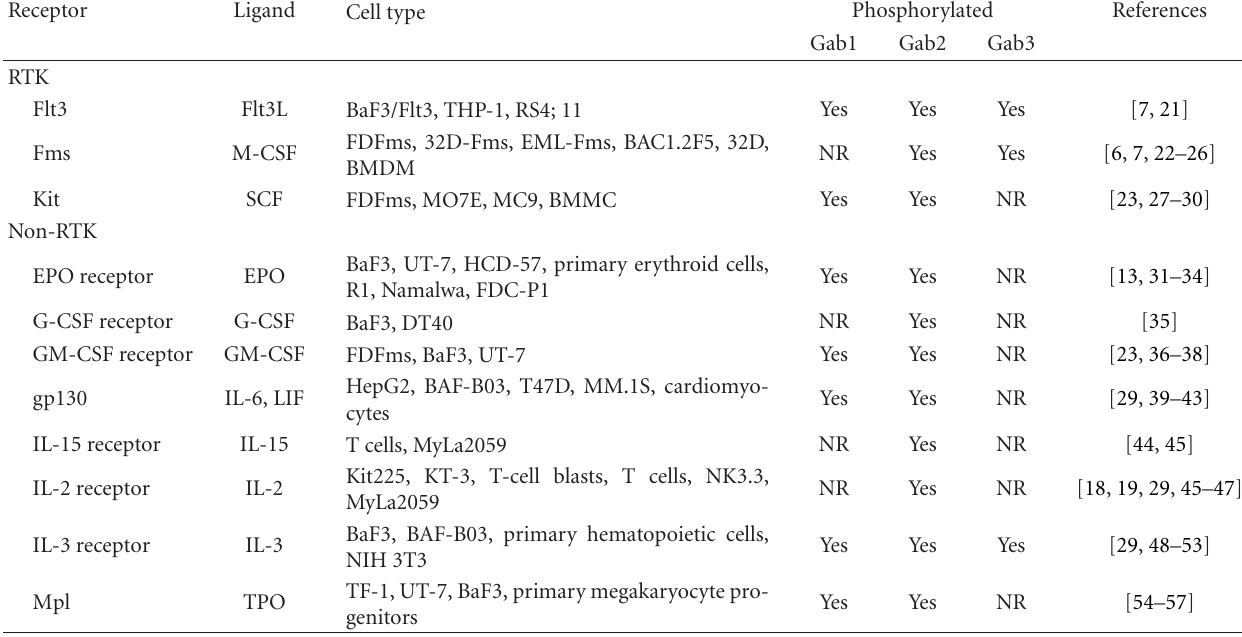
Table 1: Gabs are associated with multiple common hematopoietic receptors, RTK: receptor tyrosine kinase. Receptor